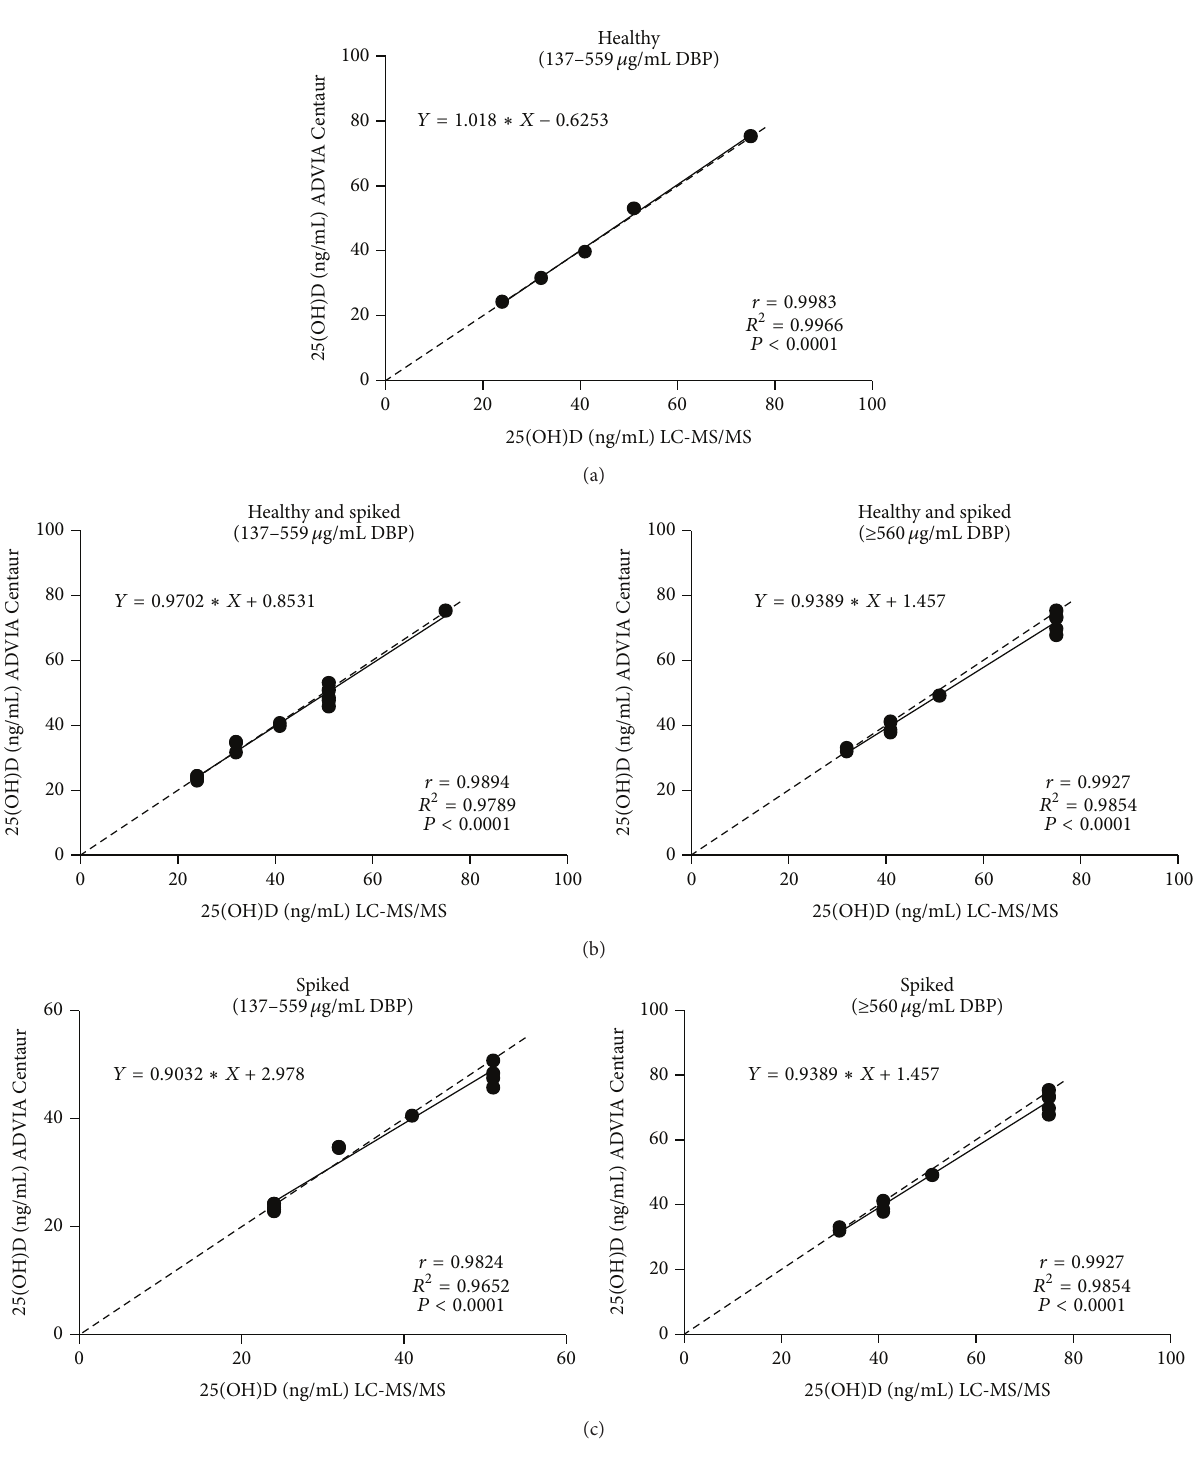
Figure 3: Correlation of 25(OH)D results obtained from the ADVIA Centaur Vitamin D Total assay and the LC-MS/MS method for normal human serum pooled samples: (a) endogenous, (b) endogenous and endogenous + spiked, and (c) endogenous + spiked. Dotted line: line of identity. To convert 25(OH)D concentrations to nanomoles per liter (nmol/L), multiply by